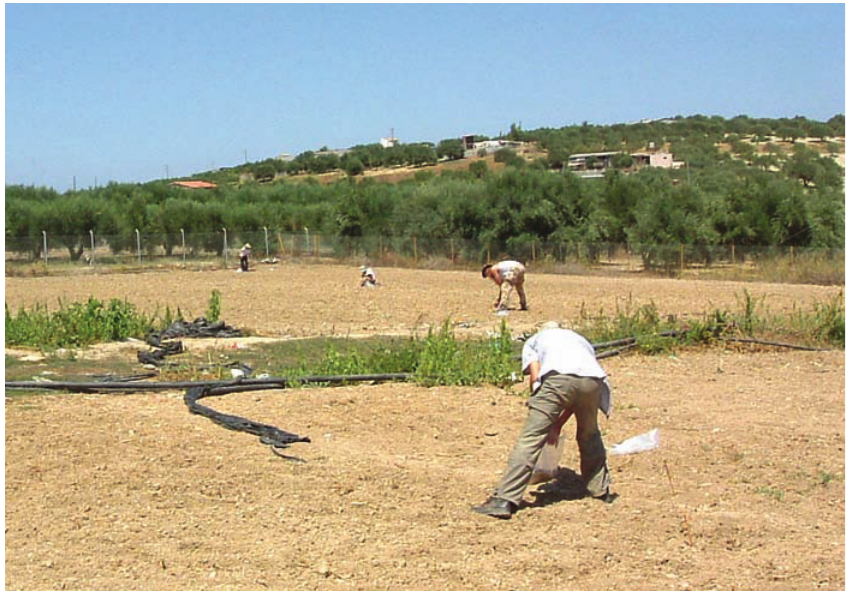
Figure 5 Intensive surface collection within 20m grid, on city site.